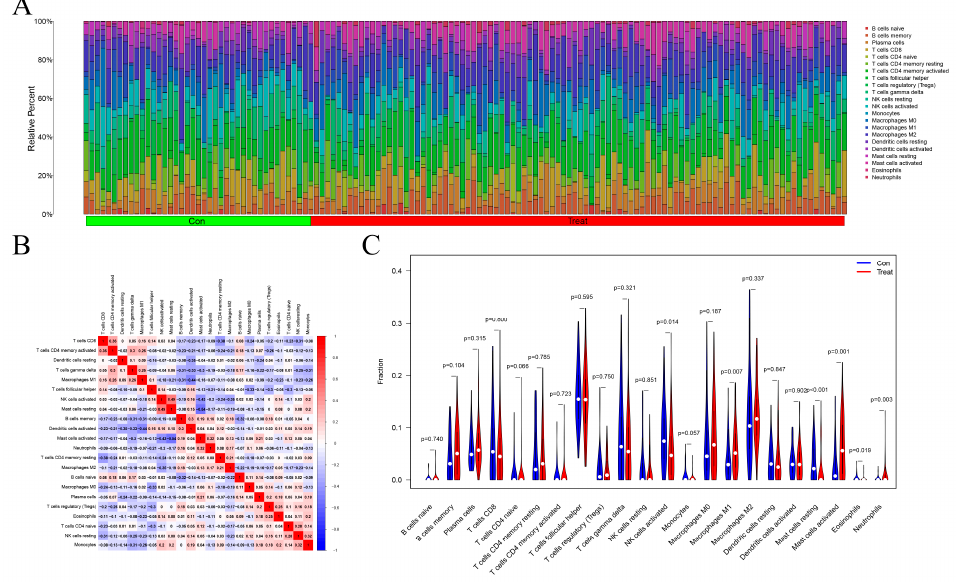
Figure 6. Tumor-immune microenvironment of EC. ( A ) Histogram of 22 types of immune cells in EC and healthy controls. ( B ) Correlation of immune cells in EC. ( C ) Violin image of immune